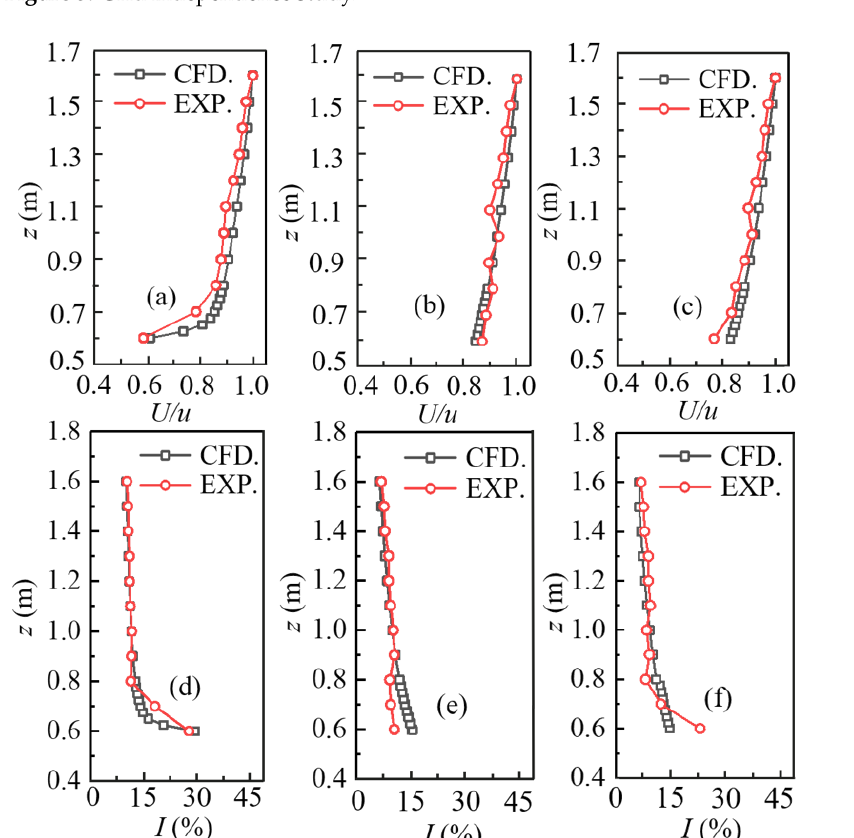
Figure 6. Comparisons of experiment and simulation results: ( a ) wind speed at point 4; ( b ) wind speed at point 5; ( c ) wind speed at point 6; ( d ) TI at point 4; ( e ) TI at point 5; ( f ) TI at point